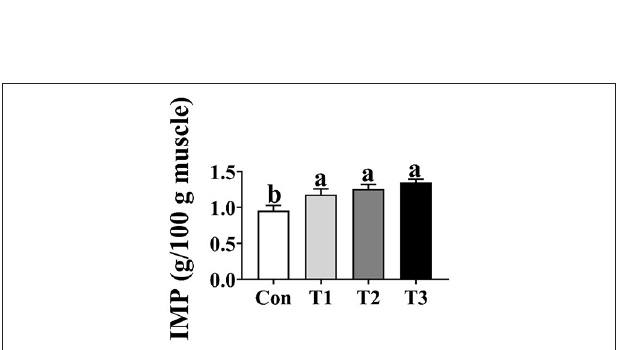
FIGURE 2 | Effects of dietary supplementation with Elephantopus scaber on IMP content in breast muscle (g/100g muscle). IMP, inosinic acid.